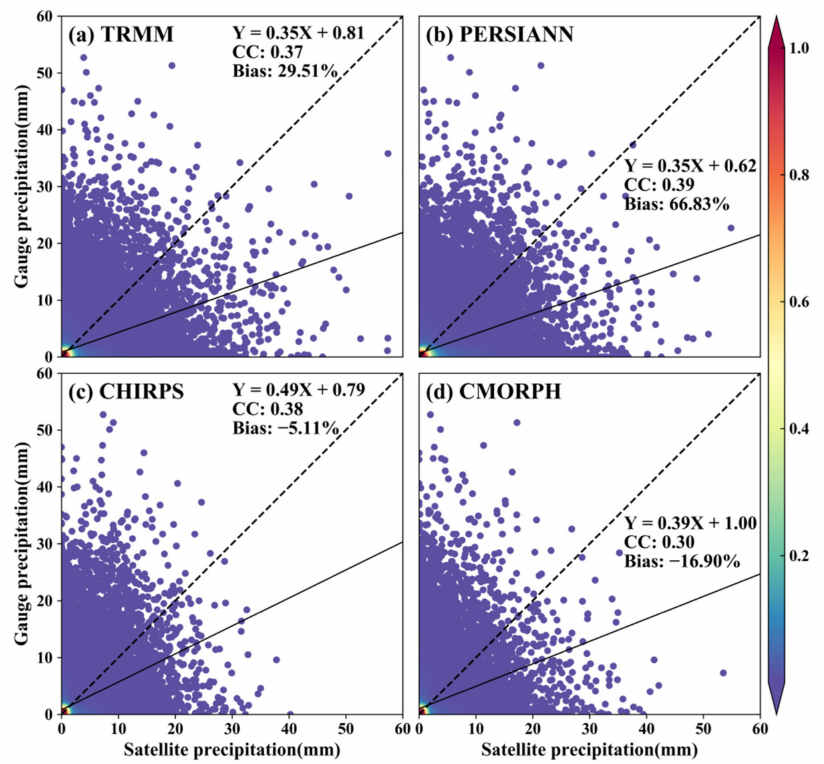
Figure 8. Scatter density plot of time series of daily precipitation from rain gauges and corresponding grids for four products from 2000 to 2008: ( a – d ) plots of TRMM, PERSIANN, CHIRPS, and COMRPH,